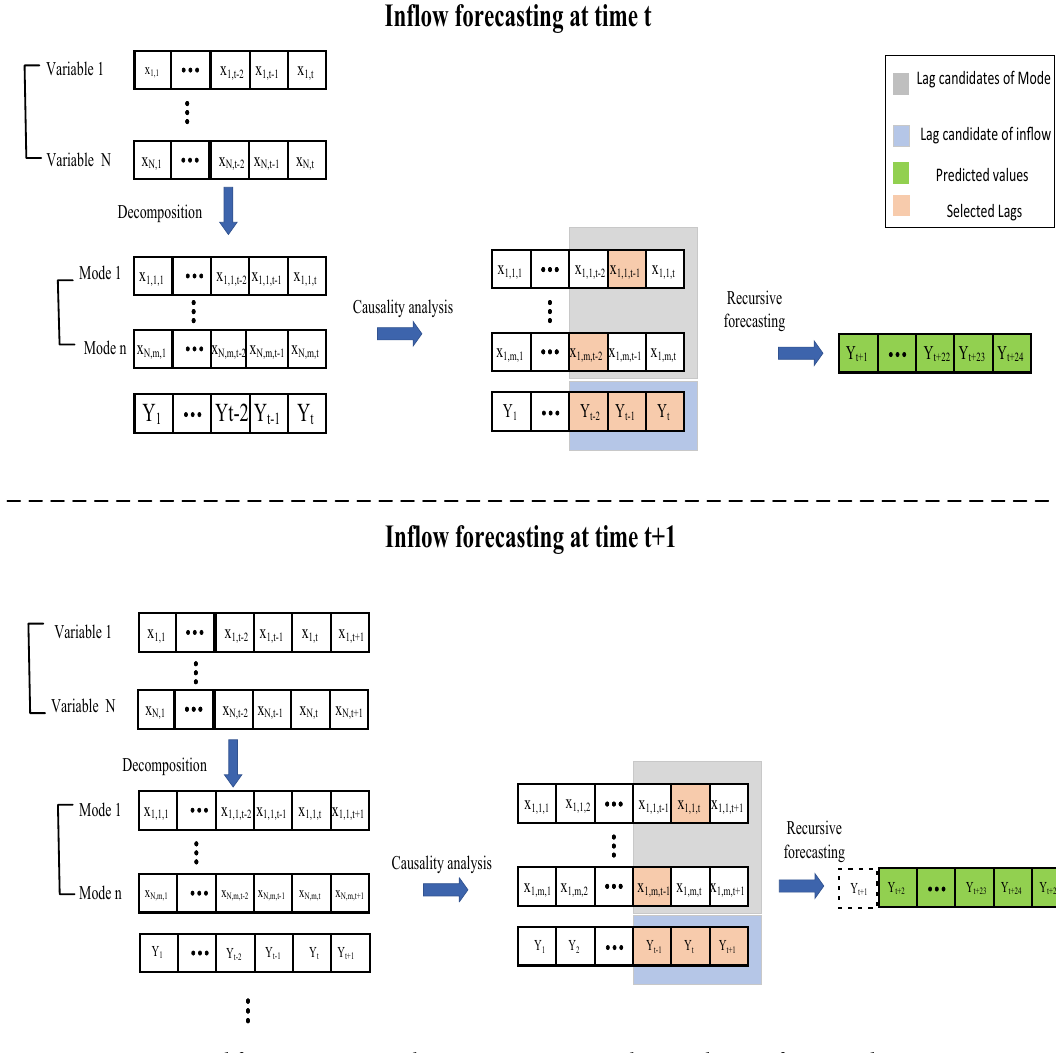
Figure 4. Actual forecasting practice by using Step-wise sampling mechanism for VMD